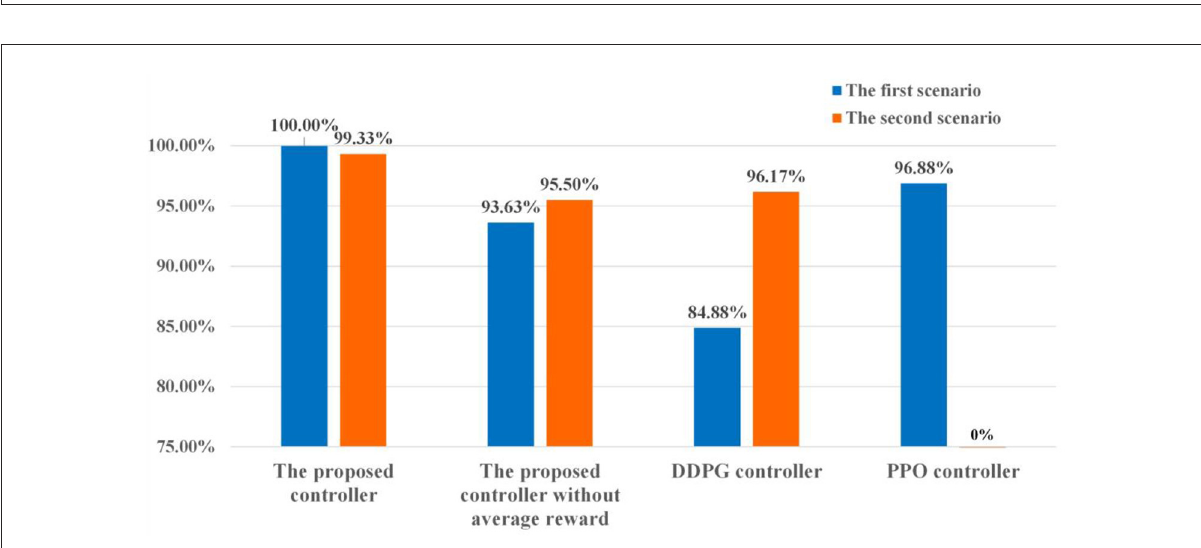
FIGURE12 The results of the reliability